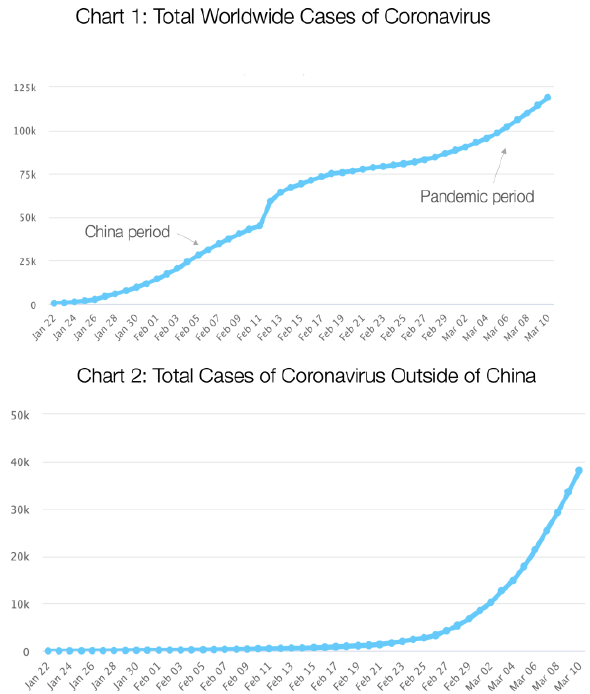
Figure 3(a), 3(b). Exponential Growth of Coronavirus infection spread globally